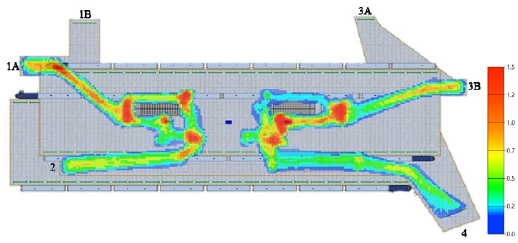
Figure 22. Simulation results of combined